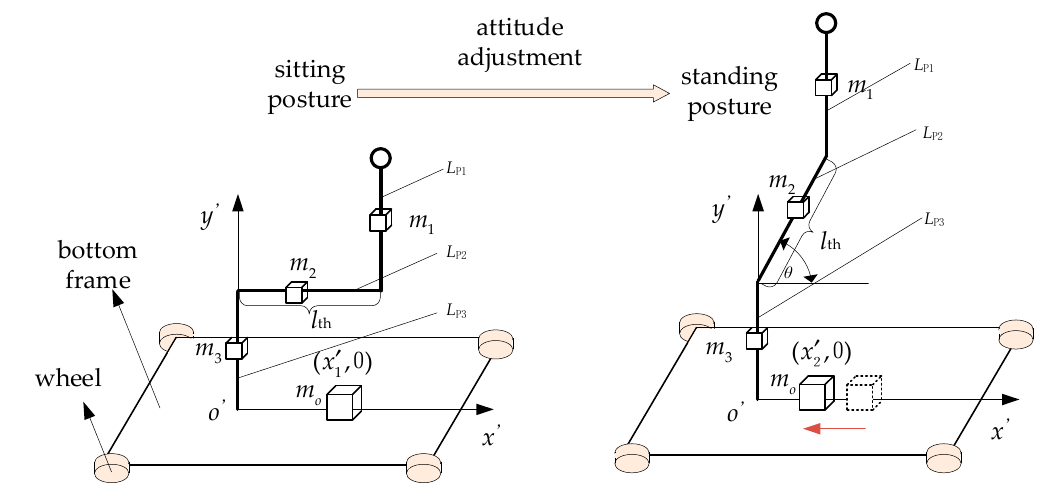
Figure 6. Stability analysis in attitude adjustment.